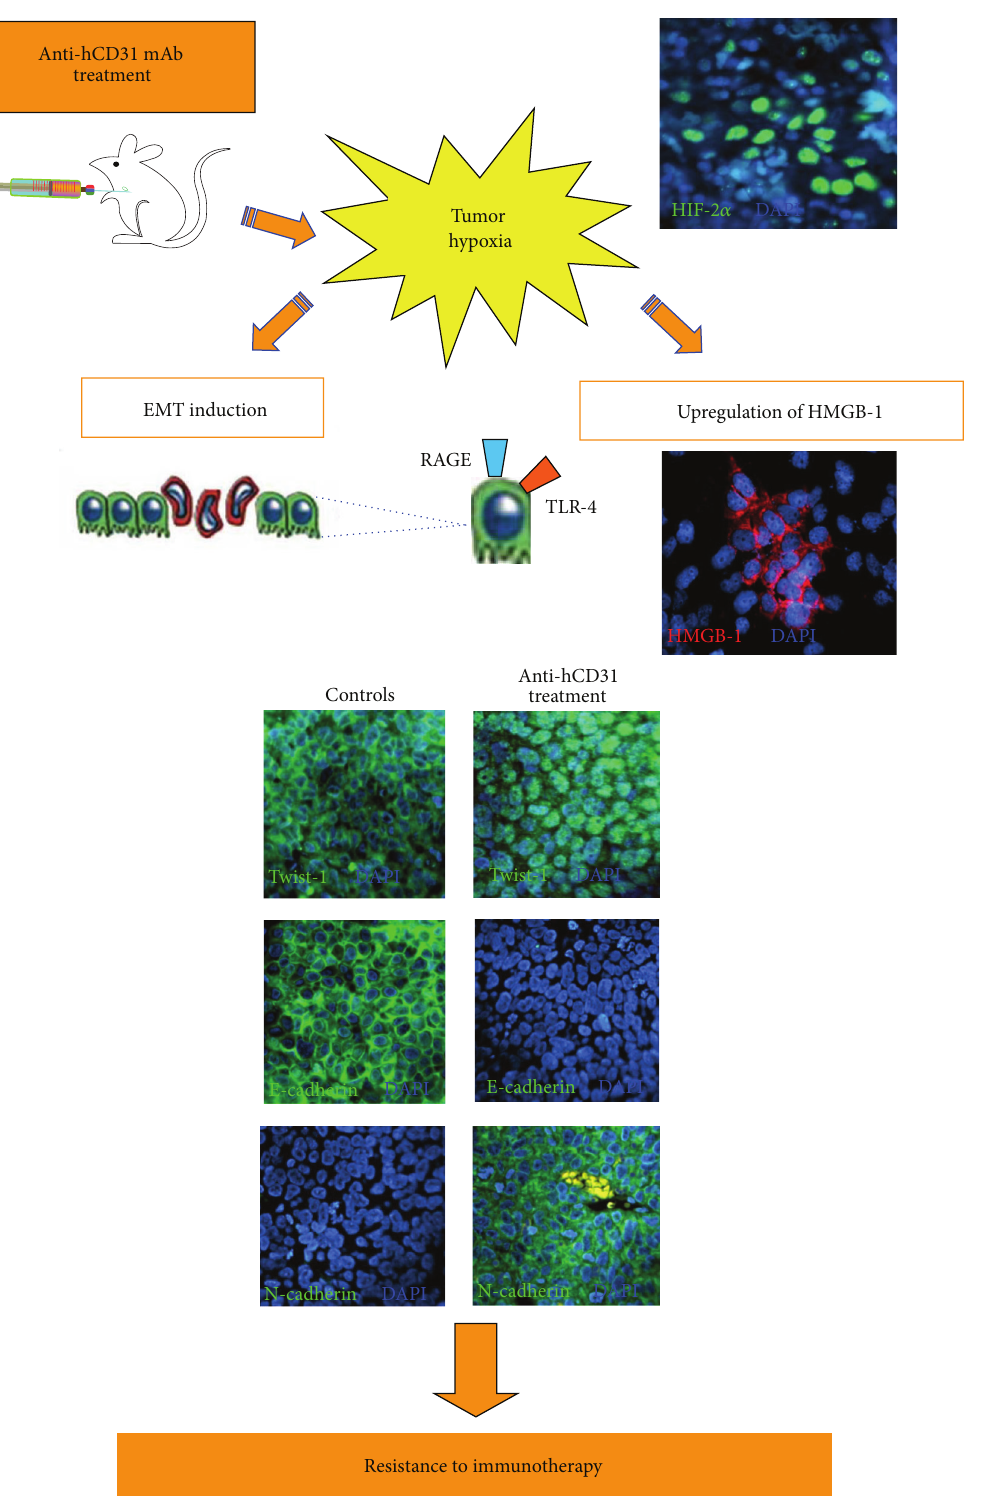
Figure 2: A model for HMGB1 involvement in resistance to mAb-based immunotherapy. hCD31 mAb-driven hypoxia promotes in NB cells expression of HMGB1 that induces by itself EMT, thus mimicking the effects of hypoxia and serving as an amplification loop. All of these mechanisms in combination account for the refractoriness of NB tumors to TDEC targeting with hCD31